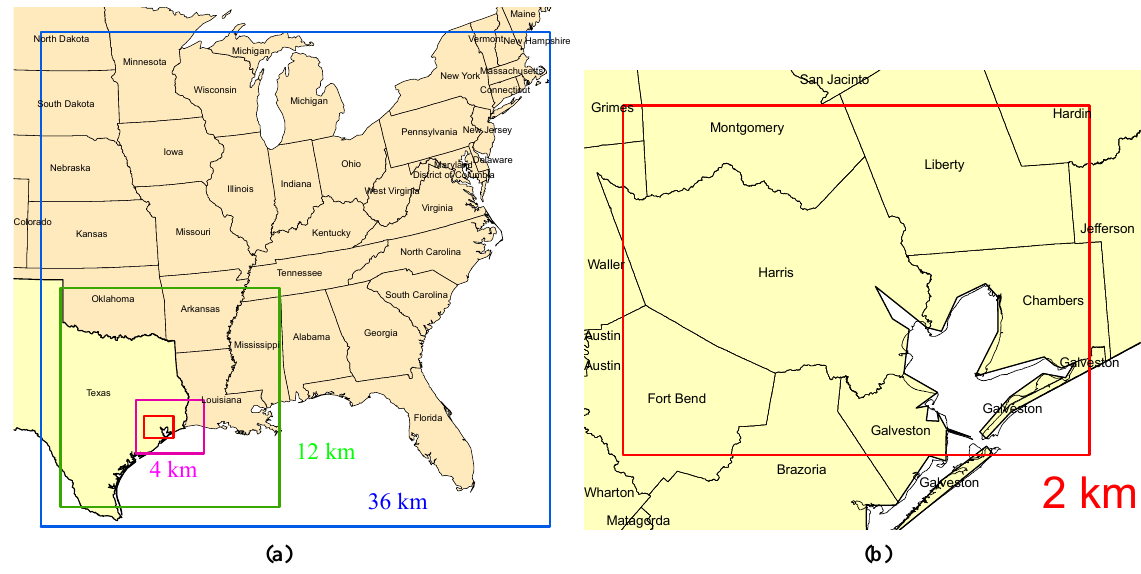
Fig. 1. CAMx Modeling domain. For each resolution, only the modeling results within the area covered by the 2km domain (the HGB area), shown above in the red box, are